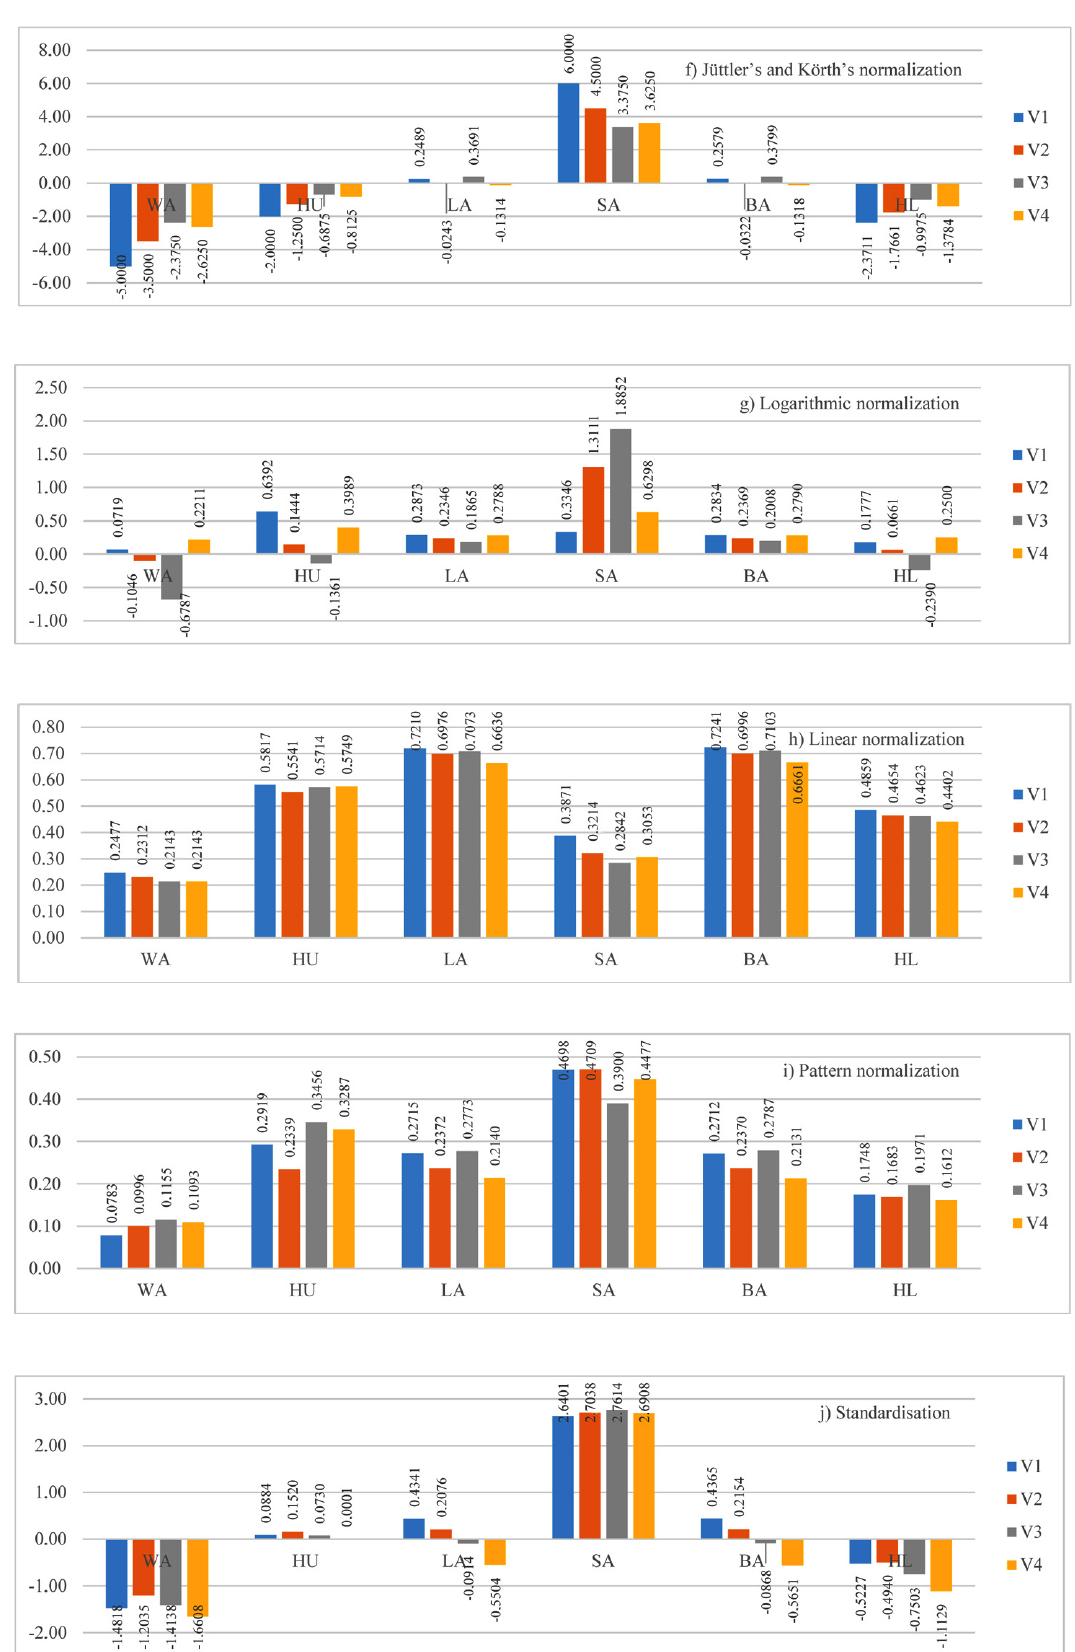
Fig. 3 (f–j). Variant ranking according to the analysed assessment